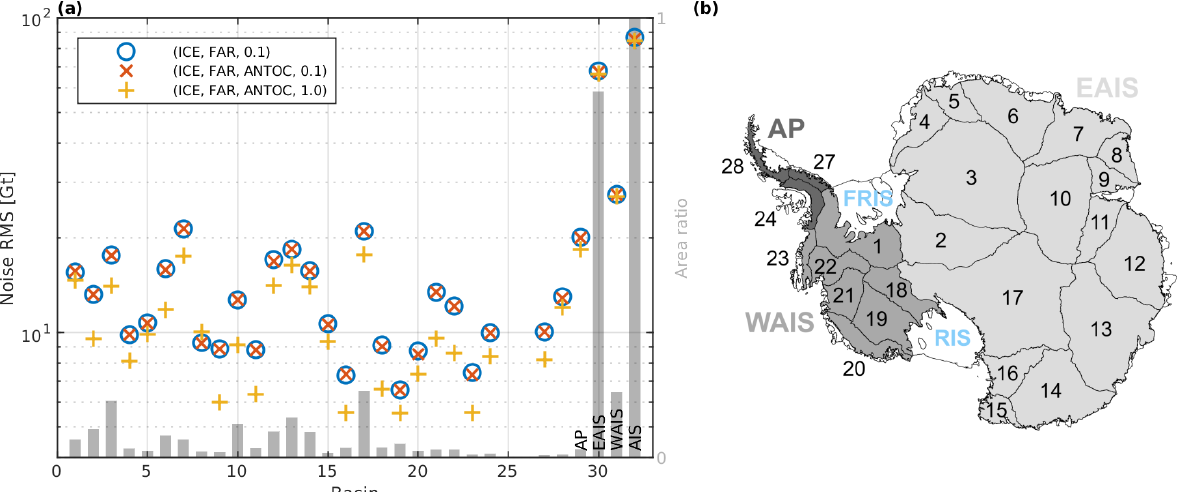
Figure 4. ( a ) Root mean square of the noise in gravimetric basin products for individual drainage basins and aggregations. Colored symbols indicate different realizations of tailored sensitivity kernels used to derive the basin products. Grey bars show the ratio between the basin area and the area of the entire AIS (linear scale at the right-hand side ordinate axis). ( b ) Overview of Antarctic drainage basins and aggregations (grey shades) based on the basin definitions by Zwally et al. [43]. FRIS and RIS indicate the location of the Filchner-Ronne Ice Shelf and the Ross Ice Shelf,